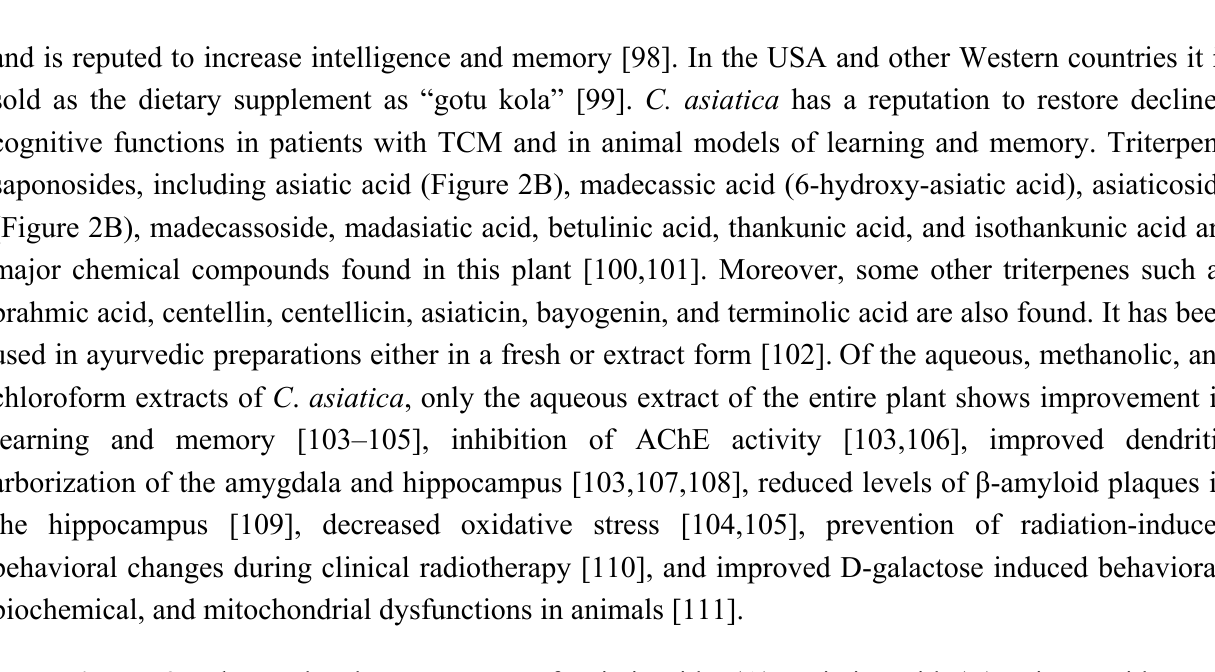
Figure 2. The molecular structures of asiaticoside ( A ), asiatic acid ( B ), ginsenoside Rb1( C ), and ginsenoside Rg1 ( D